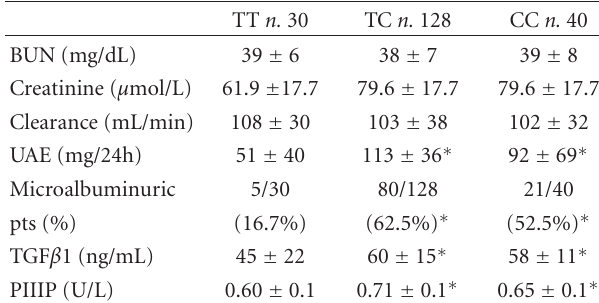
Table 3: Renal measurements, Circulating TGF β 1 and Pro-collagen III in hypertensives with left ventricular hypertrophy subgrouped according to Leu 10 → Pro 10 TGF β 1 genotypes.